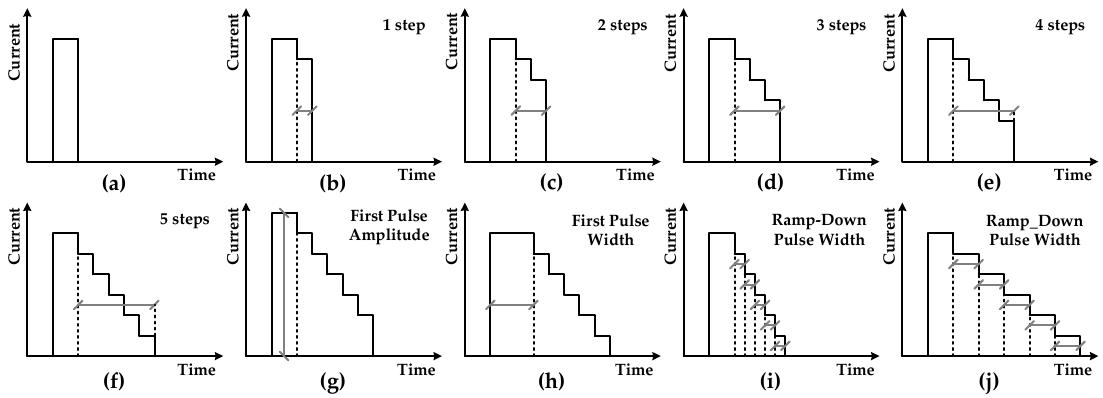
Figure 7. Programmable ramp-down current pulse for SET operation: ( a ) is a rectangular SET pulse without a ramp-down edge; ( b – f ) are ramp-down pulses with 1/2/3/4/5 steps, respectively; ( g ) is a five-step ramp-down pulse with a larger initial amplitude; ( h ) is a five-step ramp-down pulse with a larger initial width; ( i , j ) are five-step ramp-down pulses with different widths.